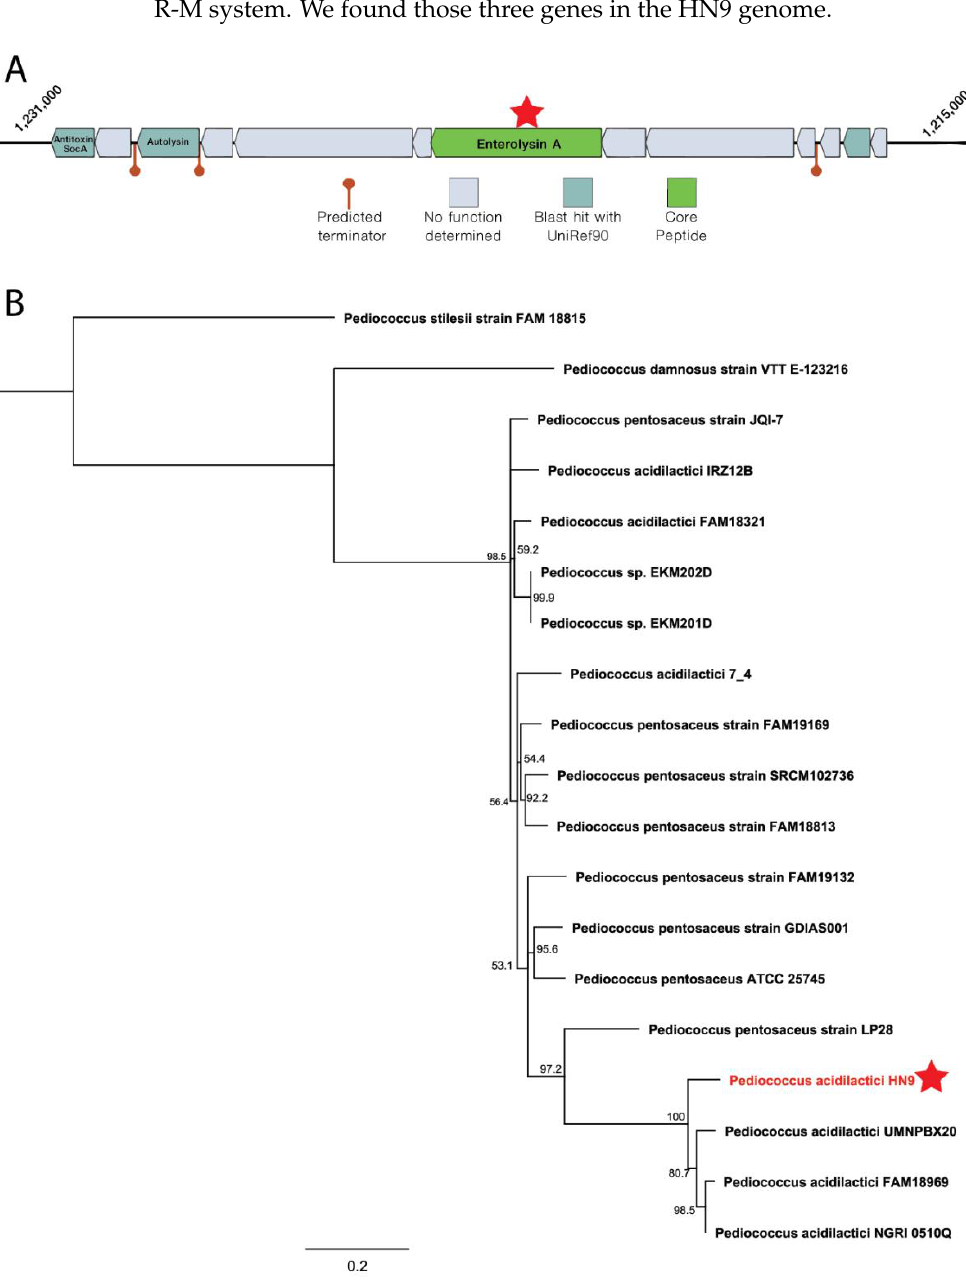
Figure 5. Antimicrobial peptides identified in the HN9 and its phylogenetic relation with other strains. ( A ) Area of Interest (AOI) of Pediococcus acidilactici in the genome within a range of 20 kb. Enterolysin A was found as a core protein surrounded by orf00004 (Antitoxin SocA), orf00007 (Autolysin), and orf00023 (uncharacterized protein). The location of Enterolysin A is marked with the red star. ( B ) Phylogenetic analysis of Enterolysin A sequences from the HN9 and other 19 strains. The red star represents the location of P. acidilactici HN9 in the phylogenetic tree.